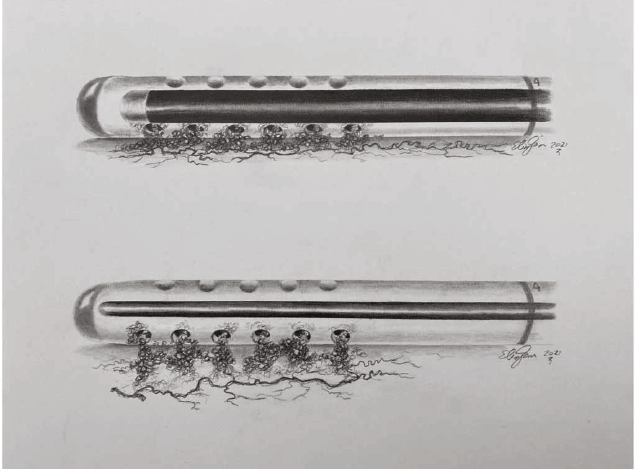
Figure 7: Comparison between endoscopic monopolar wire and stylet techniques. The endoscopic monopolar instrument (top drawing) coagulates the inner content, fi brous tissue and choroid plexus adhesions, releasing the catheter from the adherence, minimizing the risk of any blood vessel rupture during catheter removal. The monopolar wire is larger than the ventricle catheter holes and is semirigid, making it very di ffi cult to go beyond the catheter limits and damage the brain. In the stylet technique, (bottom drawing) the wire, due to its rigidity and size, can pass beyond the catheter limits and damage surrounding brain tissue. Furthermore, the thickness of the stylet does not fi ll completely the inner space of the catheter, leaving some scar tissue